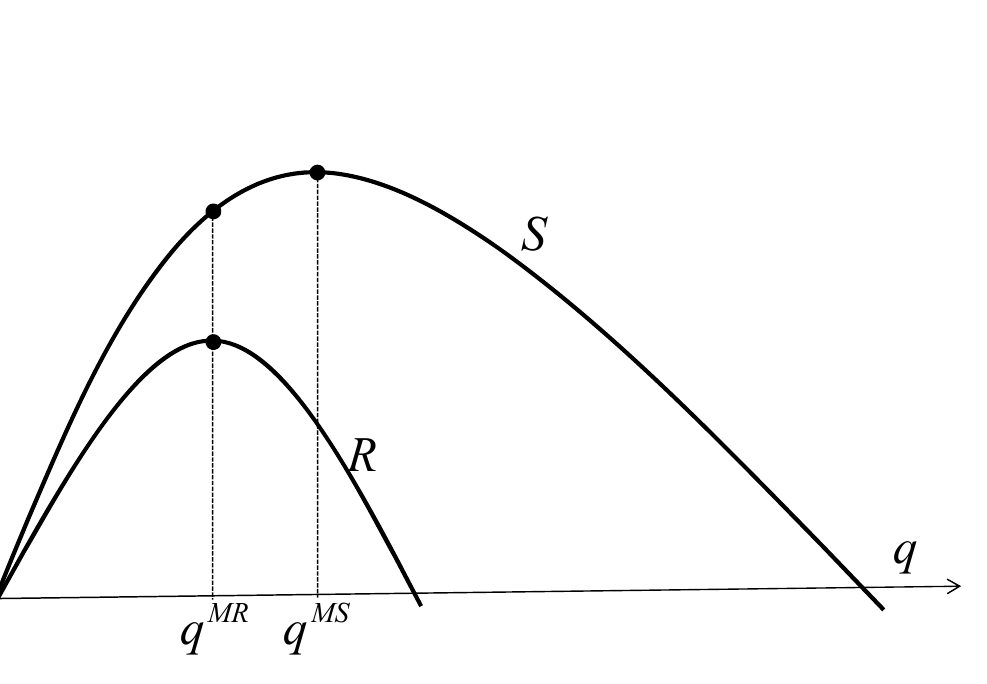
Figure 1. Graphical explanation of PI-TEP q locates in   , MS q  with the initial toll charge p , then condition When the realized demand 0 0 q and is the Pareto optimal solution of problem (13) holds. In this case, MS q strictly dominates 0 (6). And thus, we adopt SO-TEP to implement the socially optimal toll